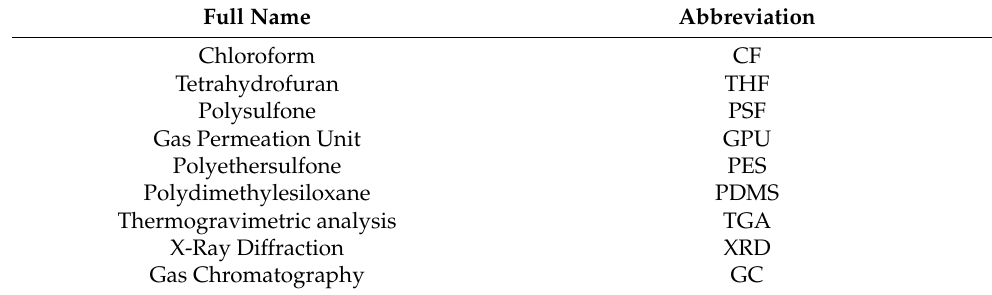
Table 1. List of